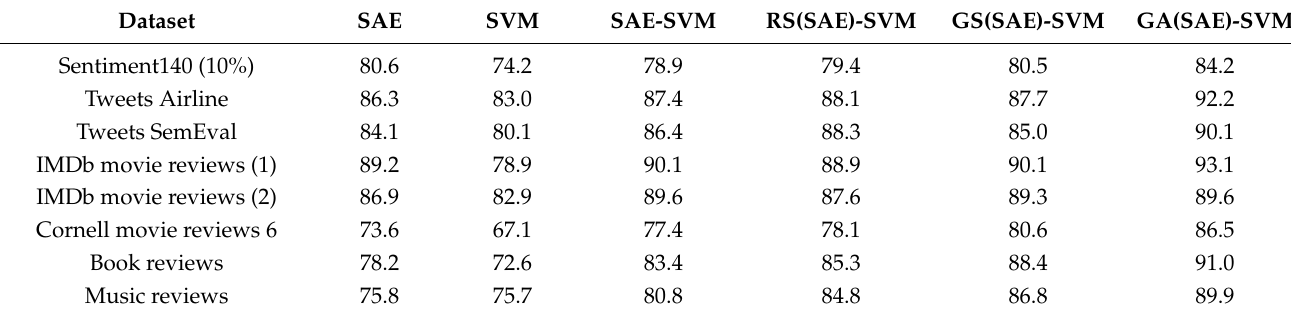
Table 8. Recall comparison for different types of datasets.